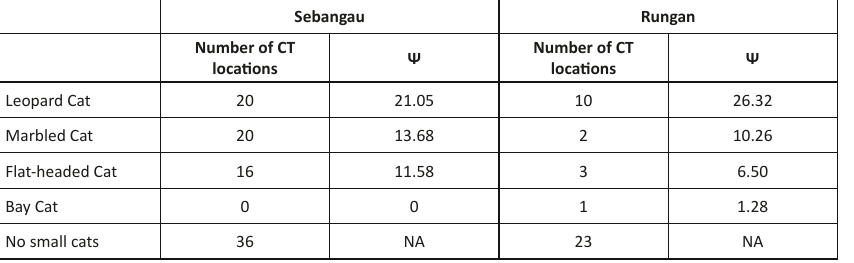
Table 3. Camera trap (CT) locations with detections and non-detections of small cats with mean occupancy estimates (Ψ) in the study sites. NA indicates occupancy cannot be calculated due to no small cats being photographed at these locations.